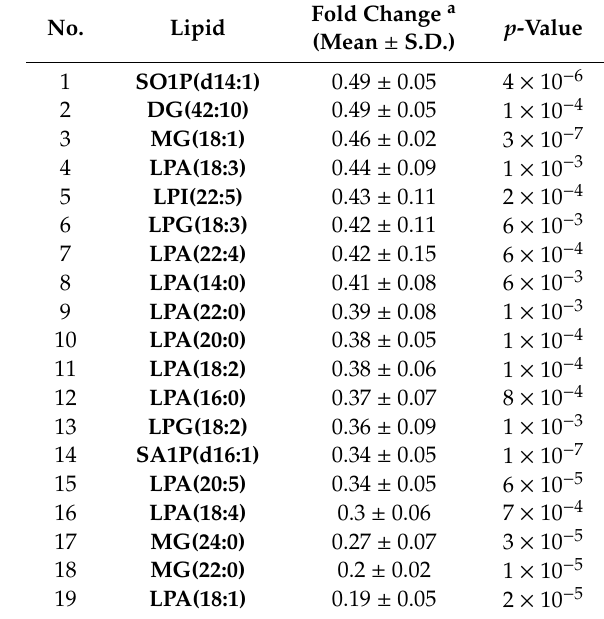
Table 4. The list of di ff erentially decreased lipid species in LEVs compared to L. plantarum . The data are shown as mean ± S.D. of the fold-decrease with p -value ( n = 9 per group; three independent biological replicates and three technical replicates). The list is displayed in descending order of fold change. Statistical significance was analyzed by Student’s t -tests for two groups. Fold Change a No. Lipid (Mean ±